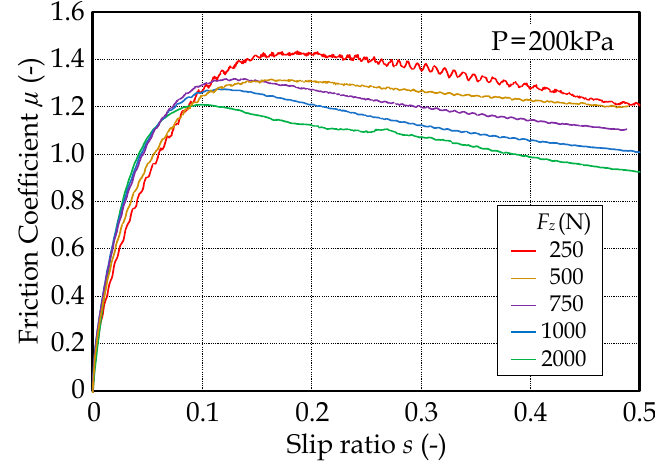
Figure 10. μ -s characteristics against load changes. Figure 10. µ -s characteristics against load